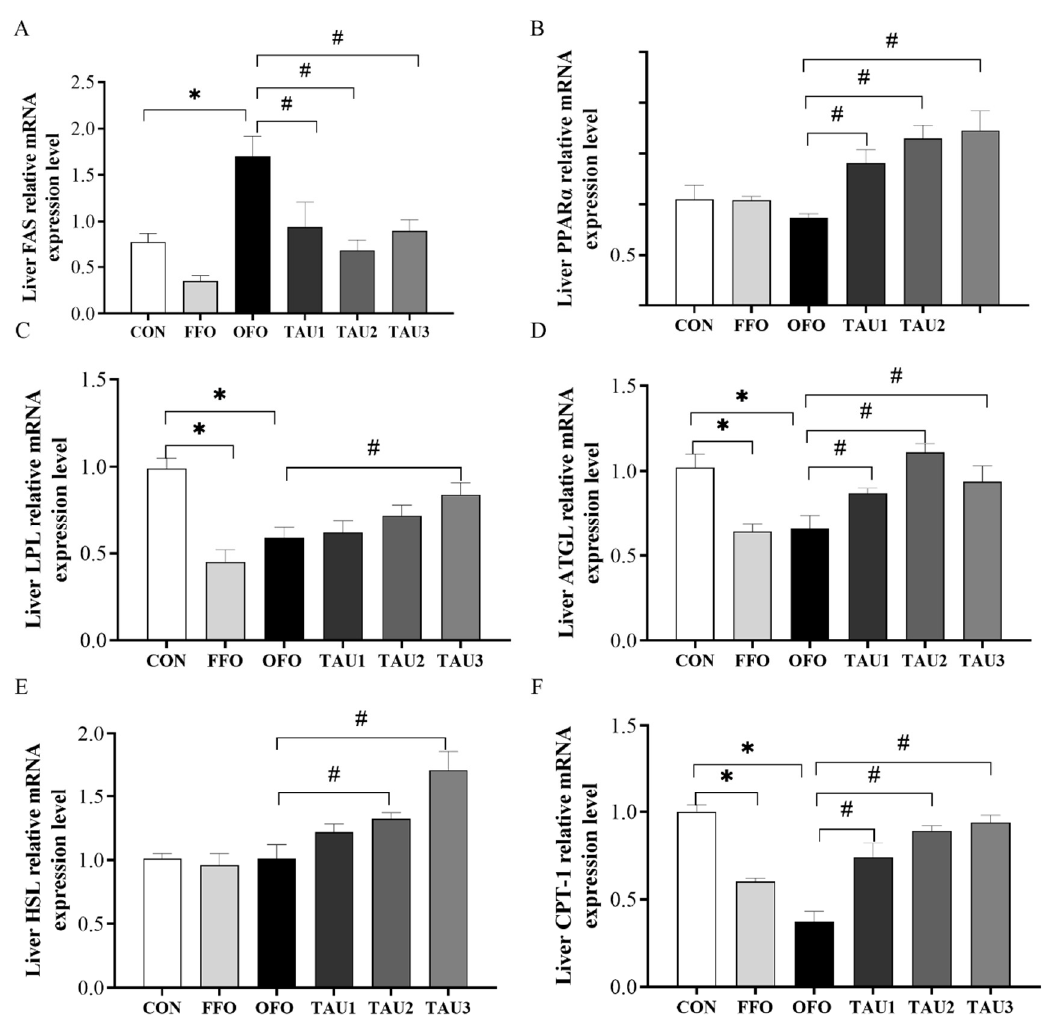
Figure 4. The relative mRNA expression levels of FAS ( A ), PPAR α ( B ), LPL ( C ), ATGL ( D ), HSL ( E ), CPT-1 ( F ) in liver of all groups of mice. ICR mice were fed a normal (CON), normal plus fish oil diet (FFO), normal plus oxidized fish oil diet (OFO), or OFO plus 0.6% (TAU1), 0.9% (TAU2) or 1.2% (TAU3) taurine diet for 10 weeks. Each value represents the mean ± SEM ( n = 10). * p < 0.05 vs. the CON group and # p < 0.05 vs. the OFO group. FAS: fatty acid synthase; PPAR α : peroxisome proliferator-activated receptor α ; LPL: lipoprotein lipase; ATGL: adipose triglyceride lipase; HSL hormone-sensitive lipase; CPT-1, carnitine palmitoyl transferase 1.